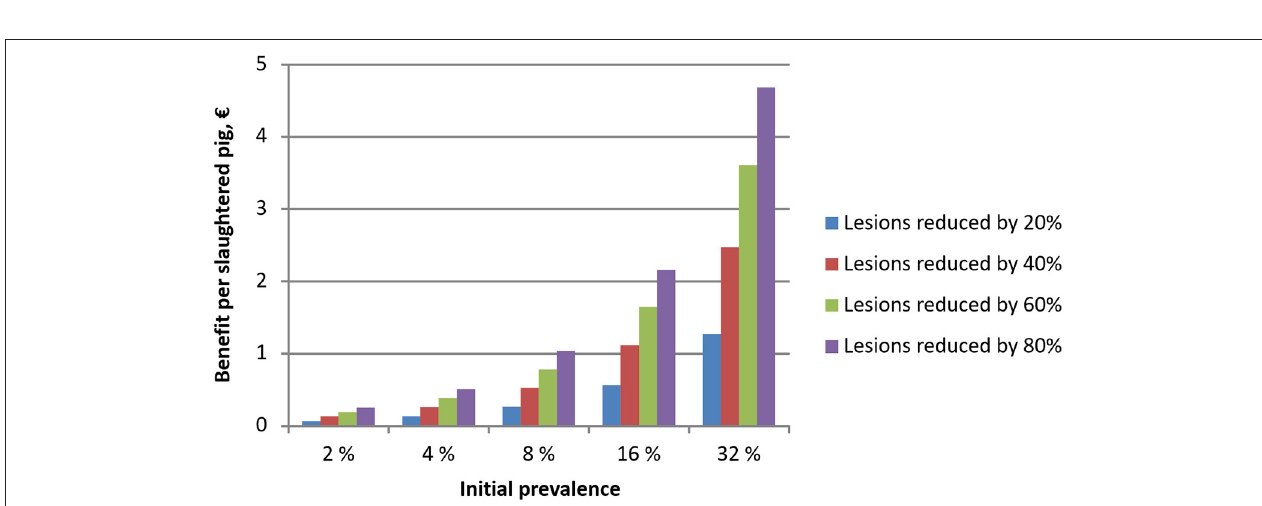
FIGURE 2 | Simulated losses due to tail biting lesions in fattening pigs at different levels of prevalence of lesions (average% pigs in a pen with tail biting lesions).